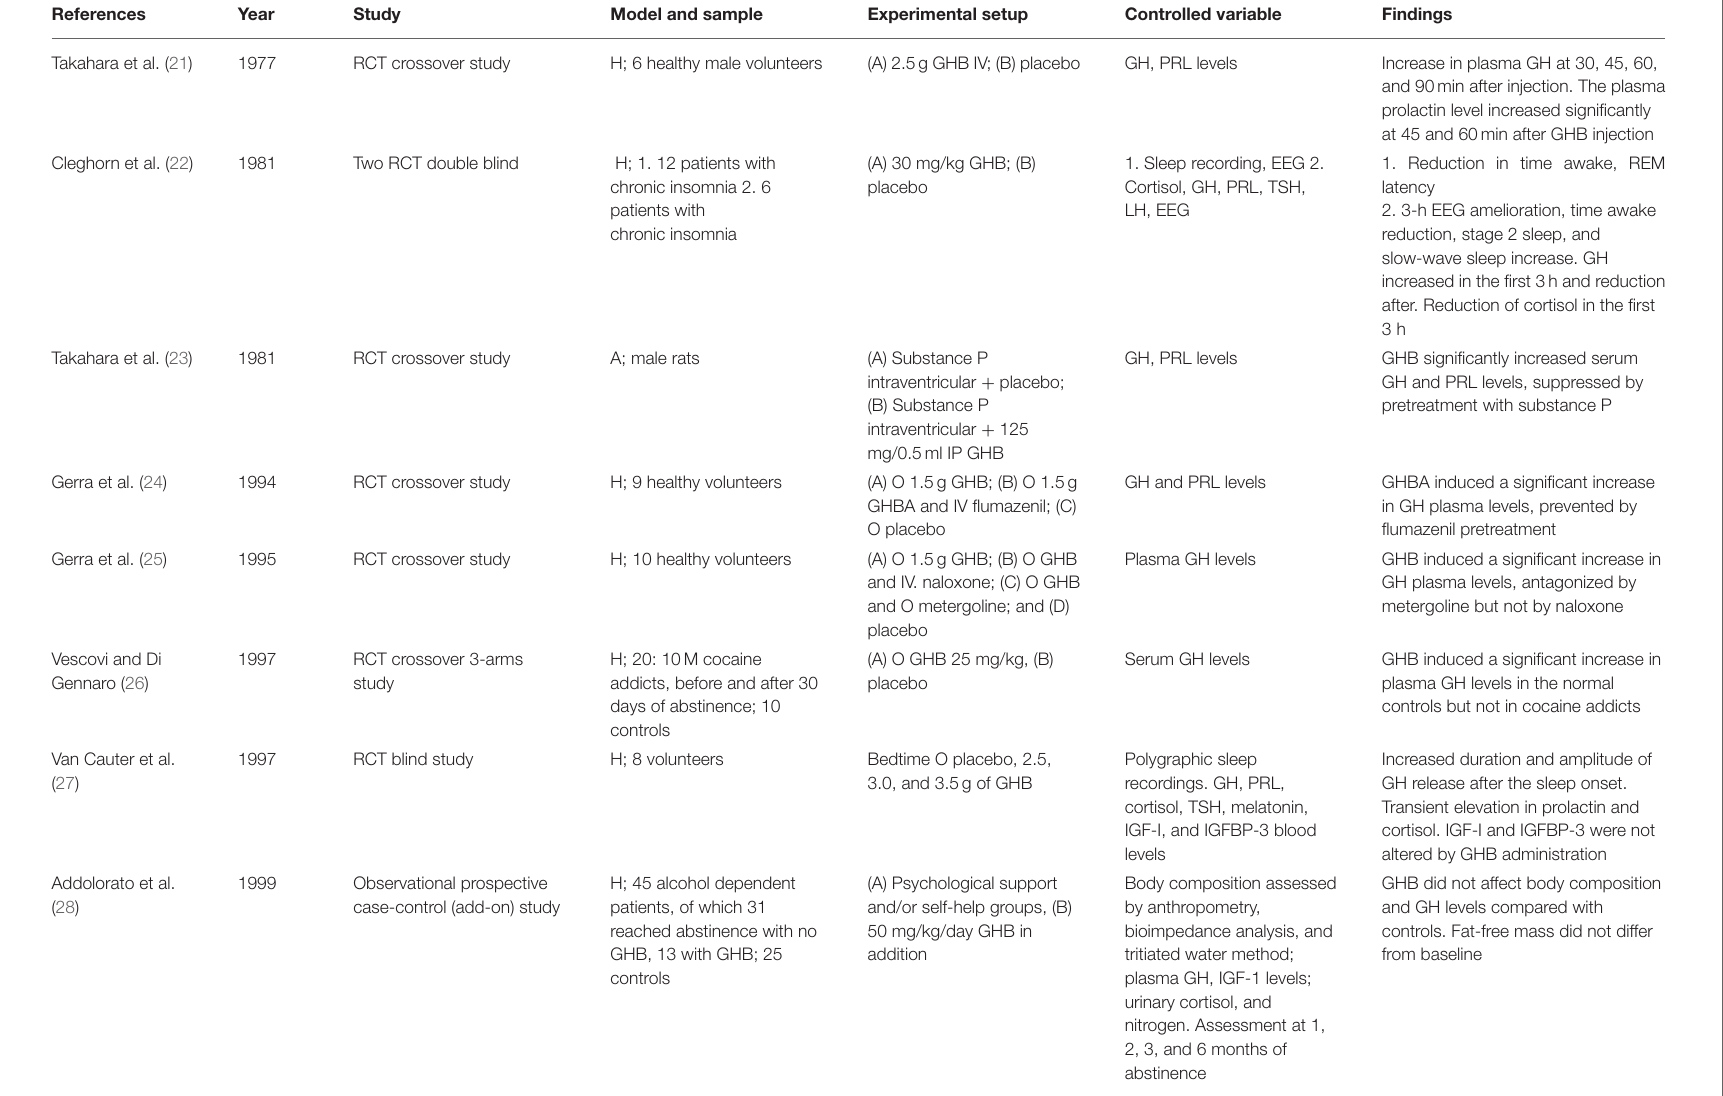
TABLE 1 | Results of the experimental